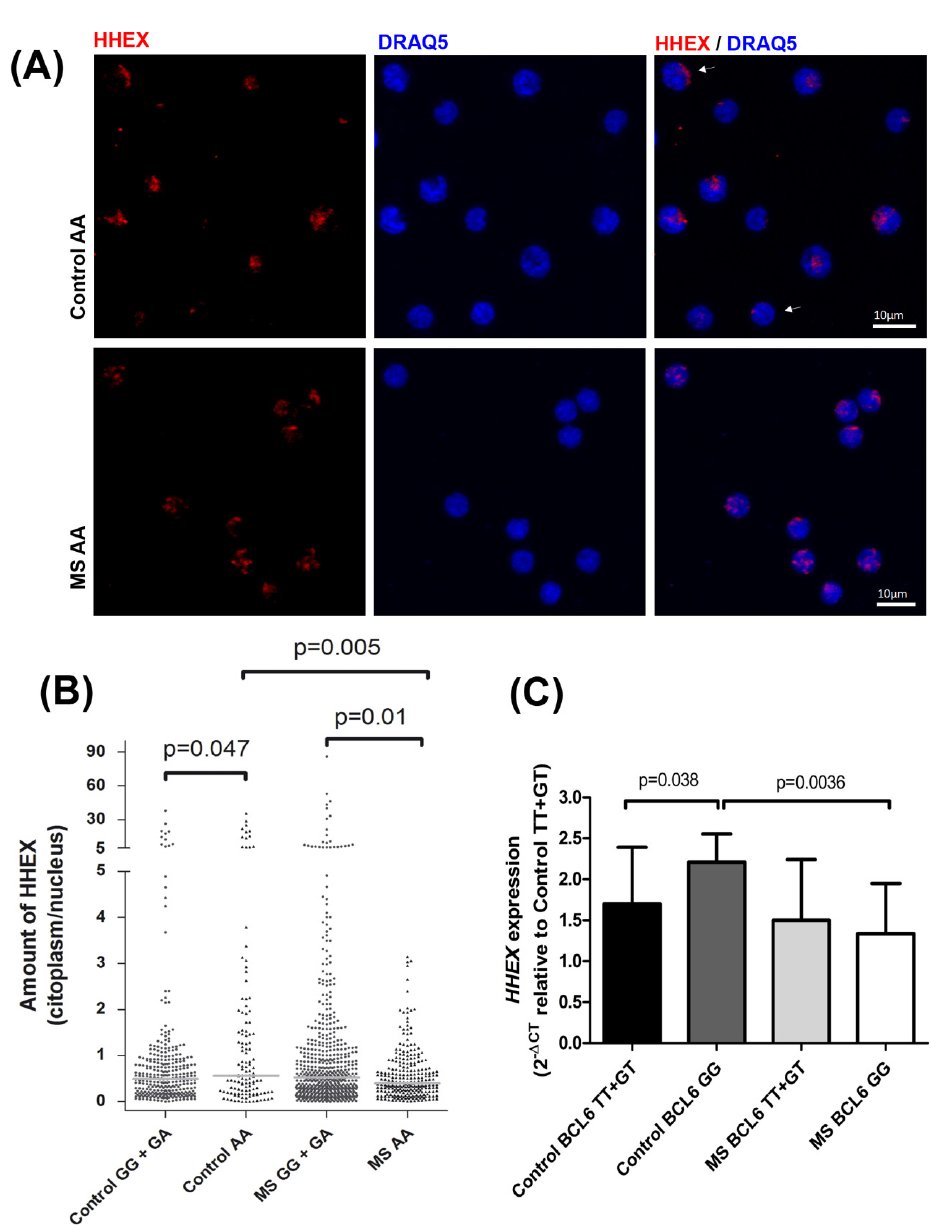
location of HHEX in MS patients compared to healthy controls (Control AA median = 0.56; MS AA median = 0.39, p = 0.005, Figure 2B).